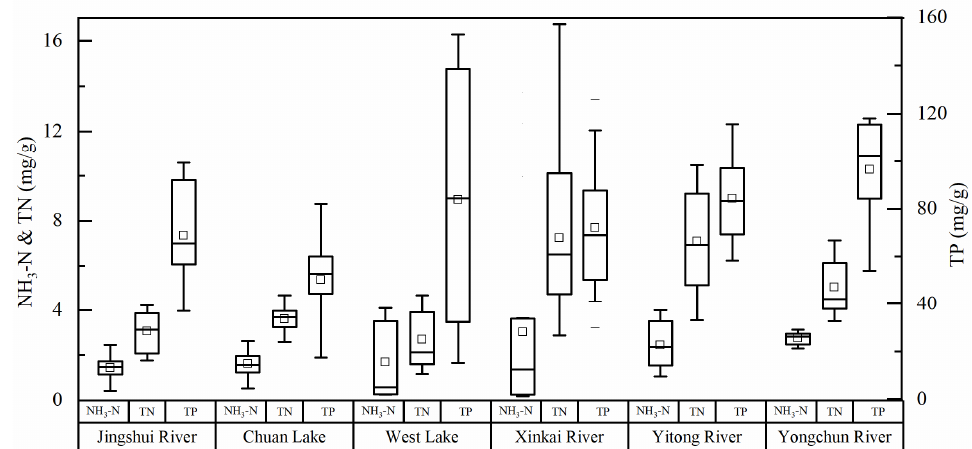
Figure 3. The content of ammonia nitrogen (NH 3 -N), total nitrogen (TN), and total phosphorus (TP) in the sediment of six rivers in Changchun City.